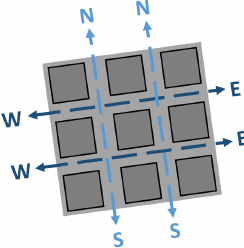
Figure 5. Possible directions in each one of six available traffic layers: W (west), N (north), E (east), and S (south).